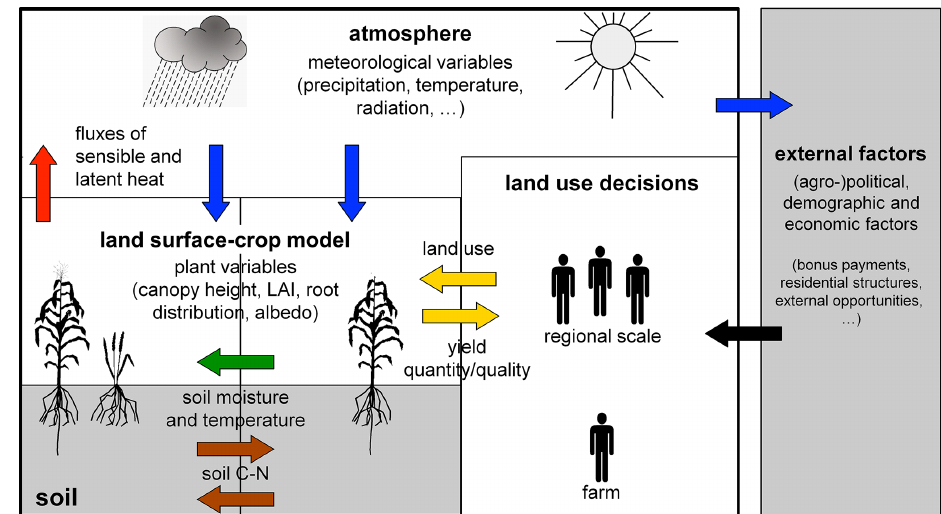
Figure 1. Diagram of the cardinal land modelling system compartments and relations. The presented dataset contains time series of quantified land surface, crops, and soil processes and properties. This serves as a unique backbone for model validation and model development in the soil–vegetation–atmosphere continuum and robust land systems